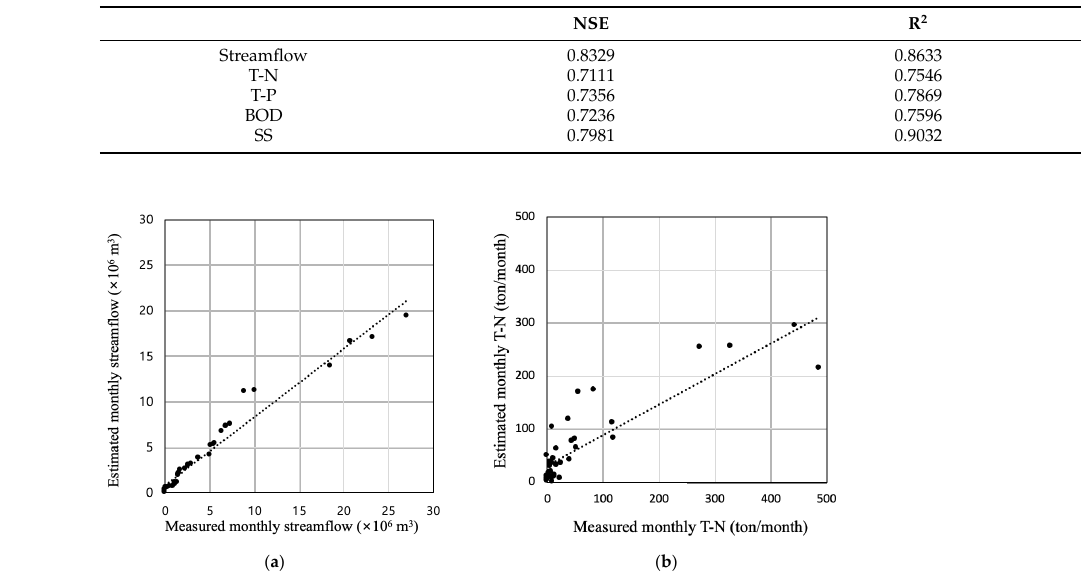
Table 4. NSE and R 2 for measured and estimated monthly streamflow in model validation.